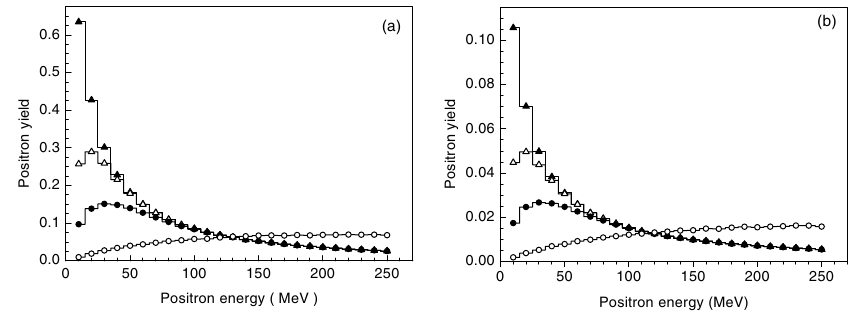
FIG. 2. Positron yield depending on energy from 2.2-mm-thick crystal (a) and amorphous (b) targets at different collimation. Filled triangles: no collimation ( # (cid:12) 24 (cid:14) ; filled circles: # (cid:12) 12 (cid:14) ; and open circles: # open triangles: # out out by